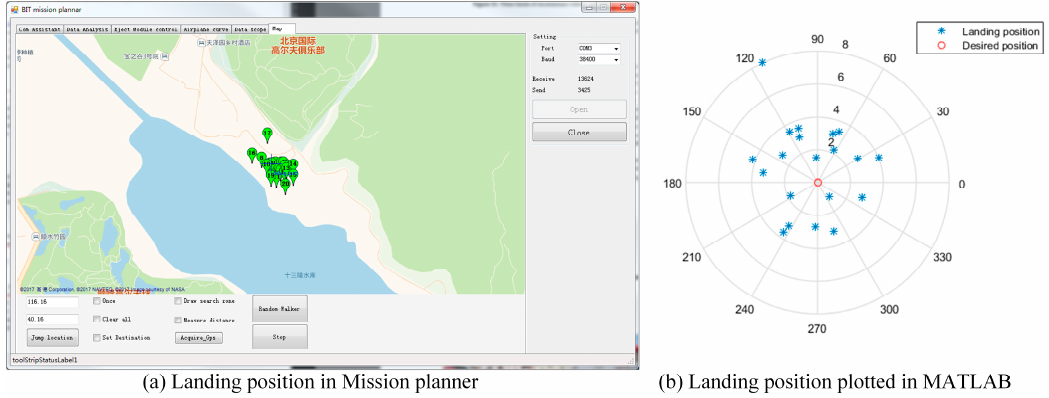
Figure 15. Landing position of the deployed ground robots.